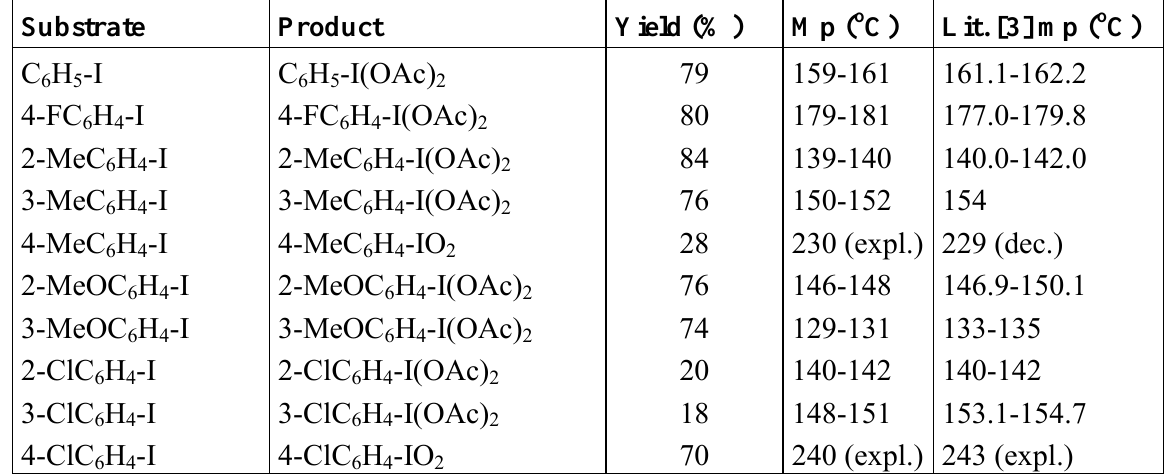
Table 1. Yields and melting points (uncorrected) of the (diacetoxyiodo)arenas prepared